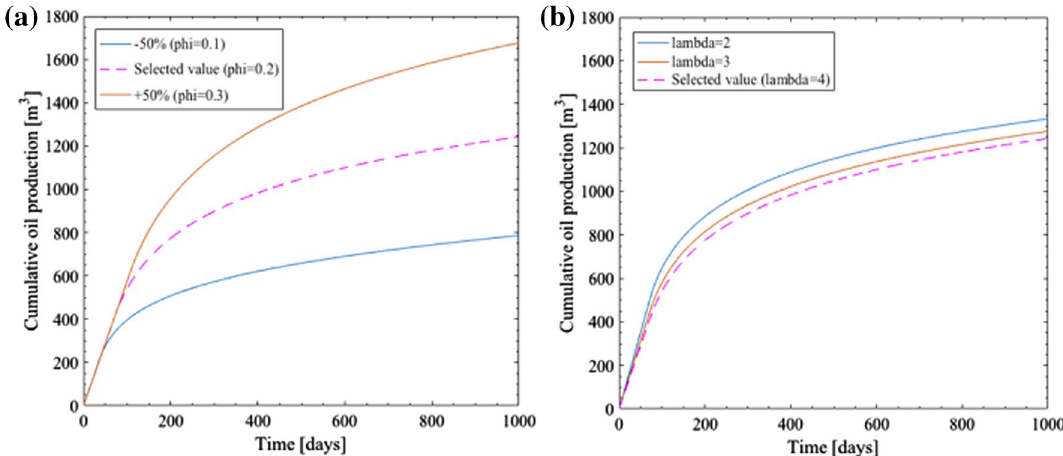
Fig. 5 Variation of cumulative oil production with: a porosity ( φ ) and b relative hydraulic permeability ( k